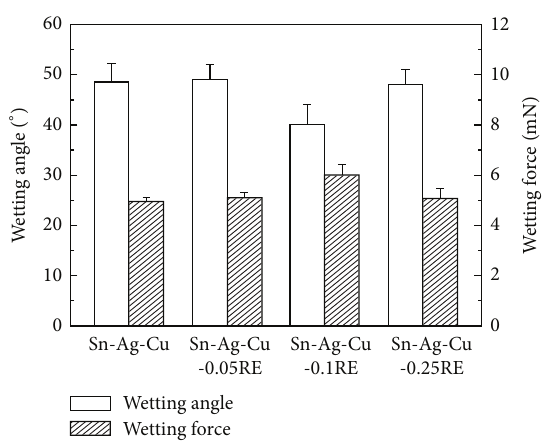
Figure 2: Wetting angle and force of Sn3.5Ag0.7Cu- x RE [35].